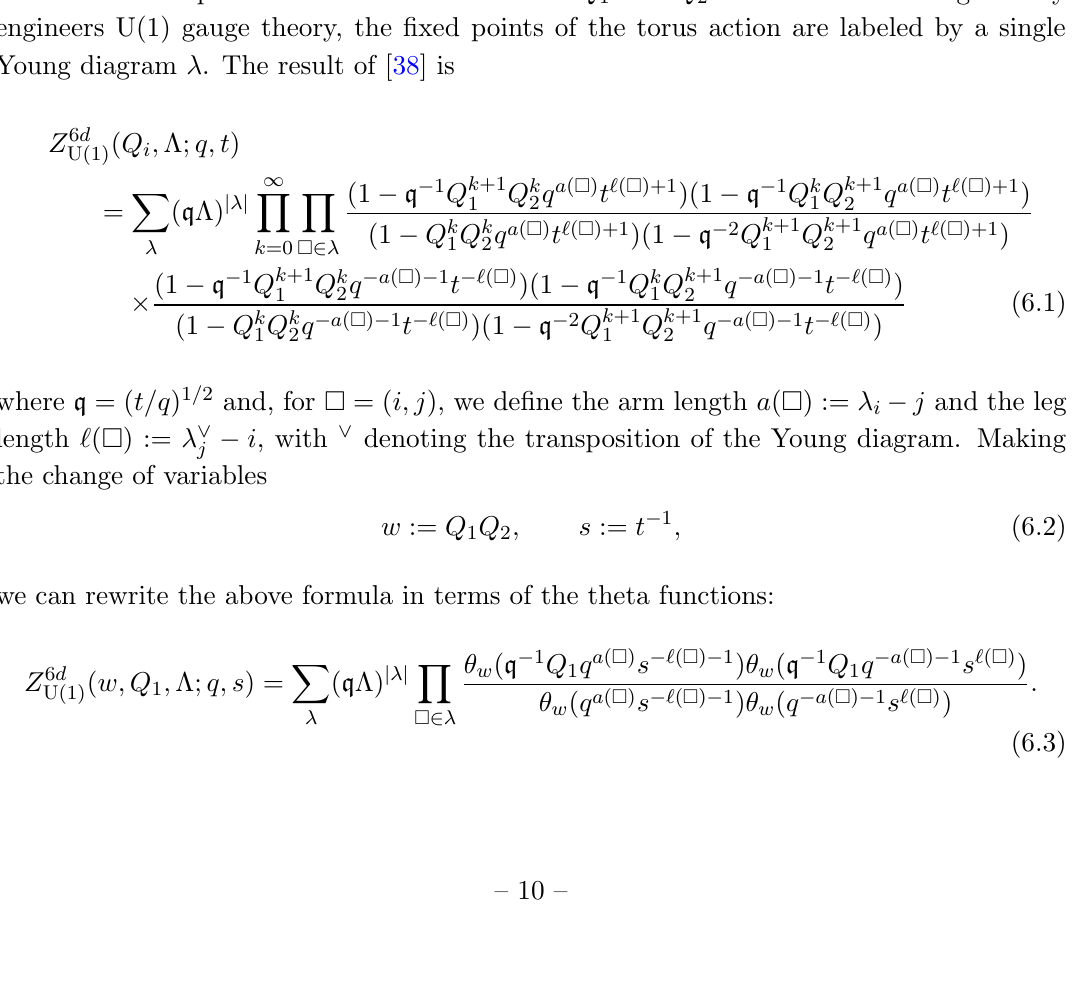
together at two punctures, while the double compacti(cid:12)cation gives a (degenerate) genus two curve consisting of a triple of rational curves attached together at two punctures (see (cid:12)gure 2). Note that the genus two curve has three moduli, which are two elliptic moduli p and w and the mass of the adjoint matter t = e (cid:0) m . Since these parameters come from the K(cid:127)ahler parameters of three rational curves P 1 , we may expect a triality among them. C 2 was computed by the method of the In [38] the (re(cid:12)ned) elliptic genus of Hilb n re(cid:12)ned topological vertex. The relevant toric diagram is the double compacti(cid:12)ed